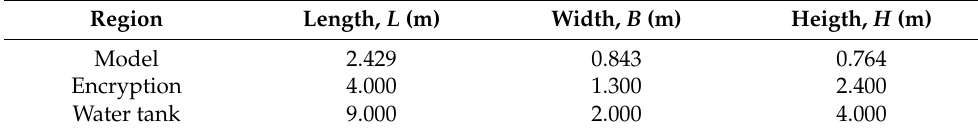
Table 5. Dimensions of three regions. Region Length, L (m) Model Encryption Water tank 9.000 4.000